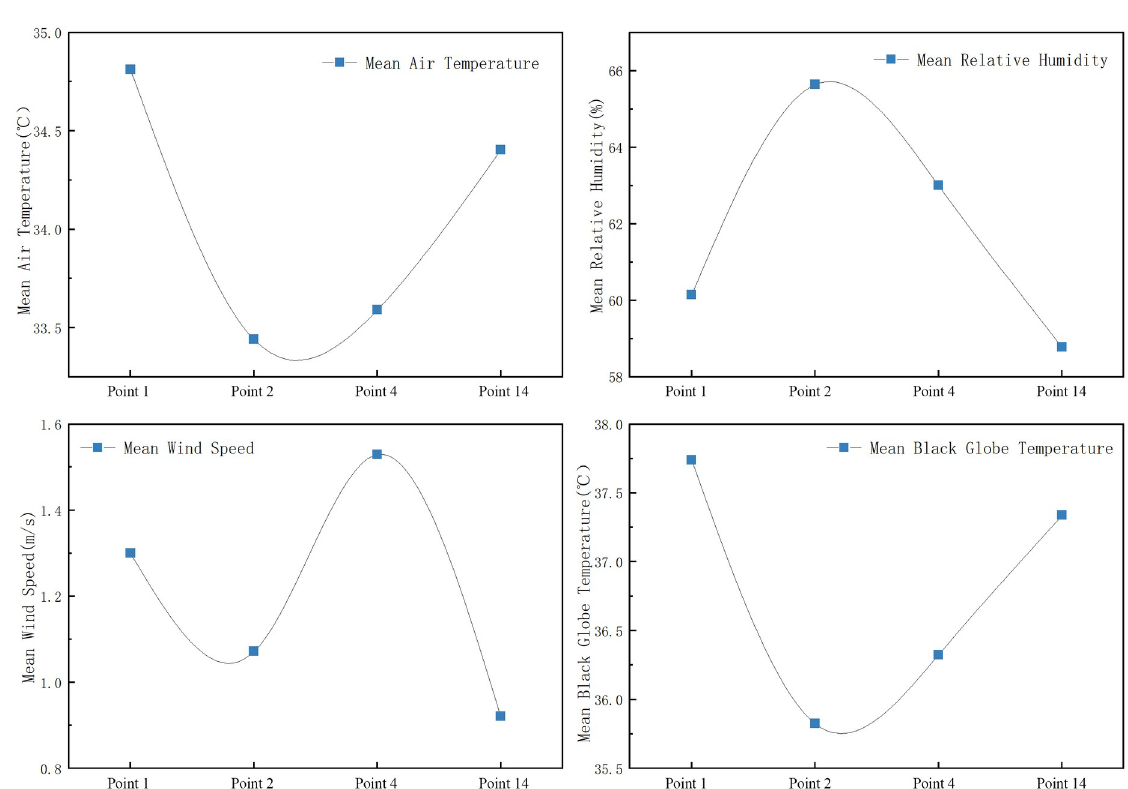
Fig 12. Mean variation of meteorological parameters at each measurement point in the